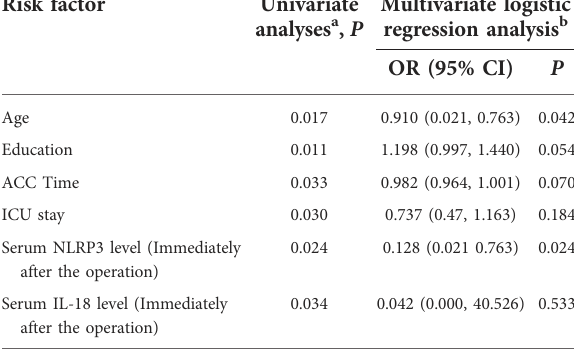
TABLE 3 Predictors of postoperative cognitive dysfunction at 1 week after